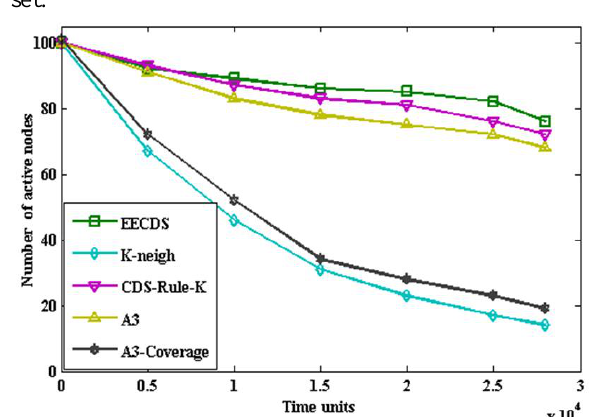
Figure 7. Network lifetime for number of active nodes